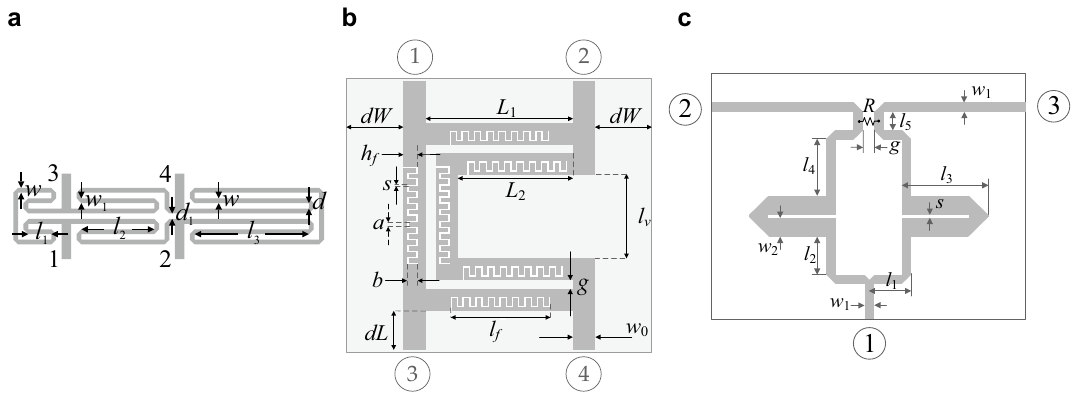
Figure 6. Microstrip components used for verification experiments: ( a ) rat-race coupler with folder transmission lines (RRC1) 67 , ( b ) rat-race coupler coupler with defected microstrip structure (RRC2) 68 , ( c ) dual- band power divider (PD), lumped resistor denoted as R 69